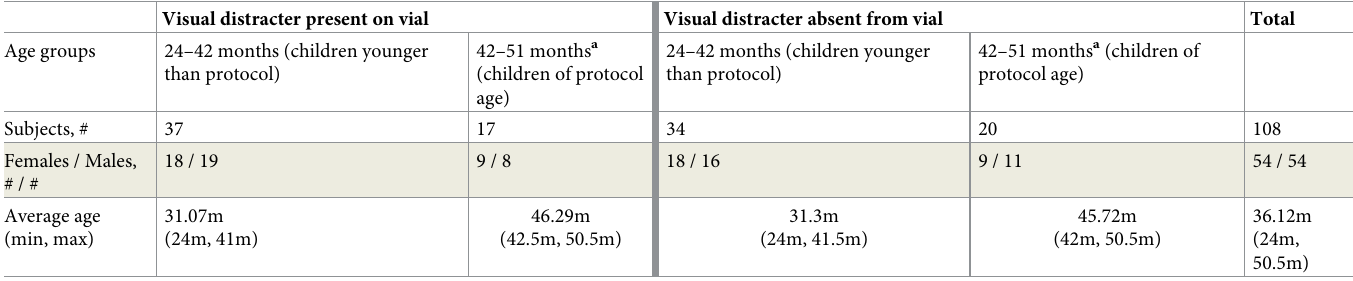
Table 2. Demographic characterization of children recruited for this study. Visual distracter present on vial Visual distracter absent from